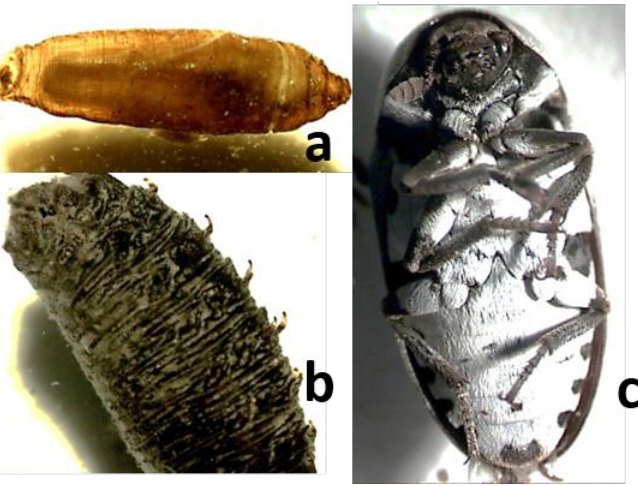
Figure 3. Entomological evidences ( a ) Piophilidae pupae ( b ) Chrysomya albiceps pupae ( c ) adult of Dermestes frischi.